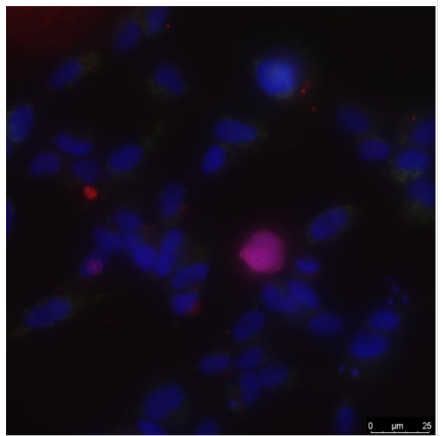
Figure 3. A typical photograph of a cell culture taken using a fluorescence